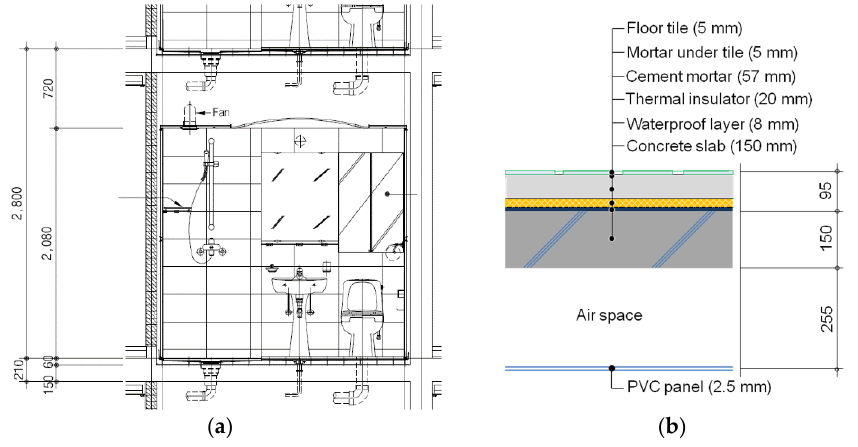
Figure 2. Cross-sections of bathrooms for which the ( a ) UBR system and ( b ) wet construction method had been applied. Table 7. Dimensions and construction methods for the bathrooms in each housing unit. Type of Housing